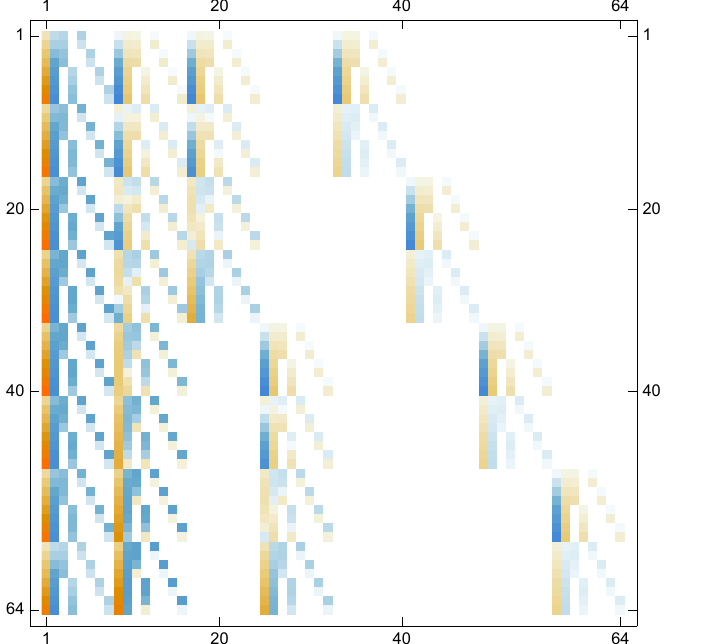
Figure 2. The visual representation of the matrix coefficient computed for Example 1 when M = 8, µ = 1, α = 3 /